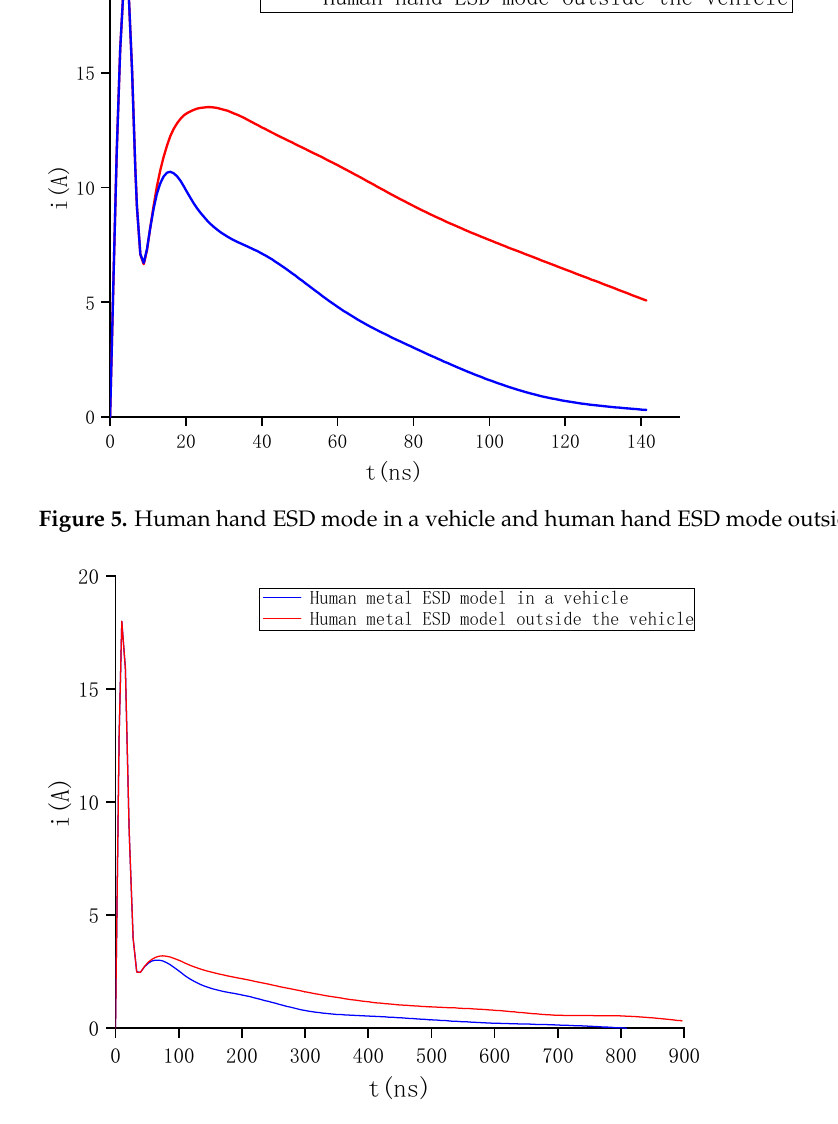
Figure 6. Human metal ESD model in a vehicle and human metal ESD model outside the vehicle.